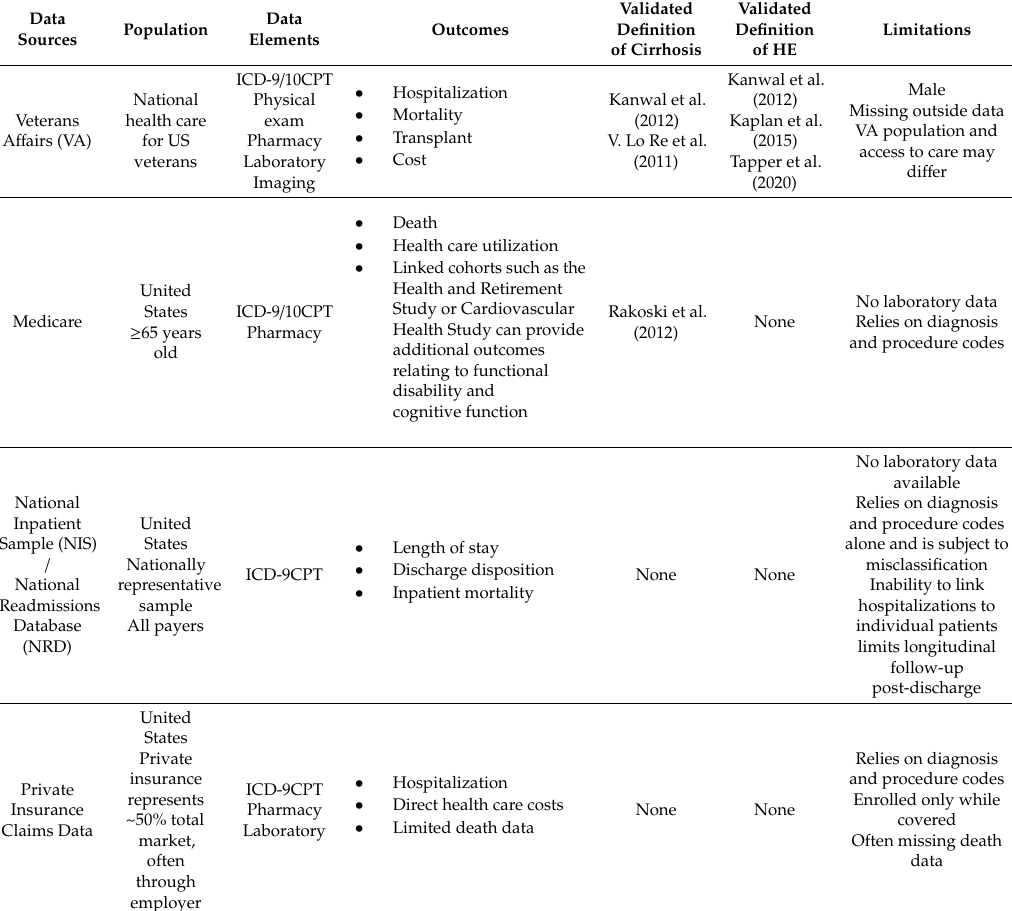
Table 2. Potential Administrative Data Sources for Hepatic Encephalopathy